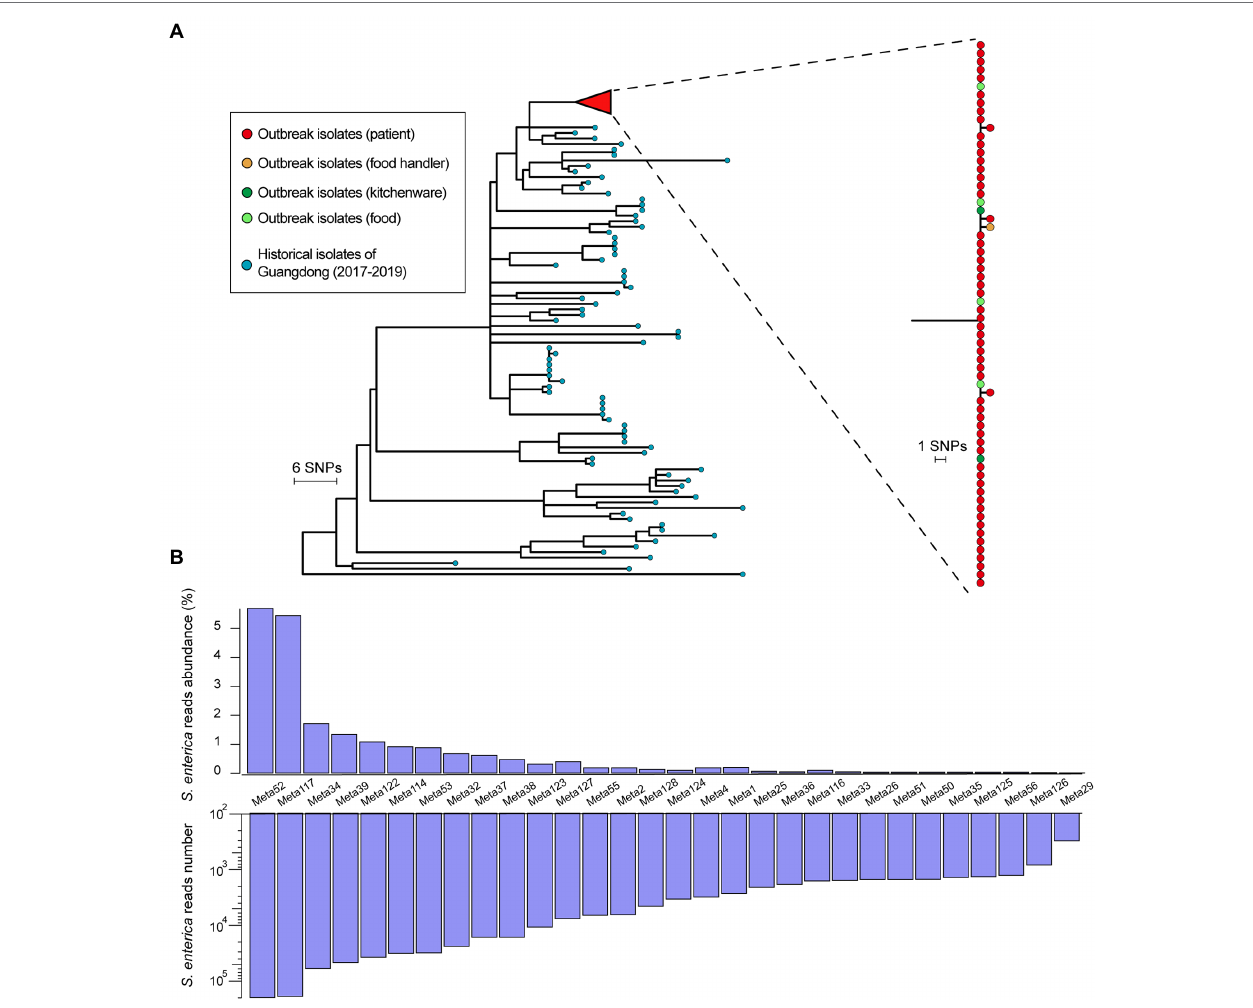
FIGURE 3 | Whole-genome and metagenomic analysis of Salmonella Enteritidis outbreak isolates and historical isolates. (A) Maximum likelihood tree of outbreak isolates ( n = 66) and historical isolates from Guangdong ( n = 81) between 2017 and 2019. Colored circles in the tree tips indicate isolate source. (B) Distributions of species-specific abundances (top) and number of reads assigned to Salmonella enterica among metagenomics samples ( n =